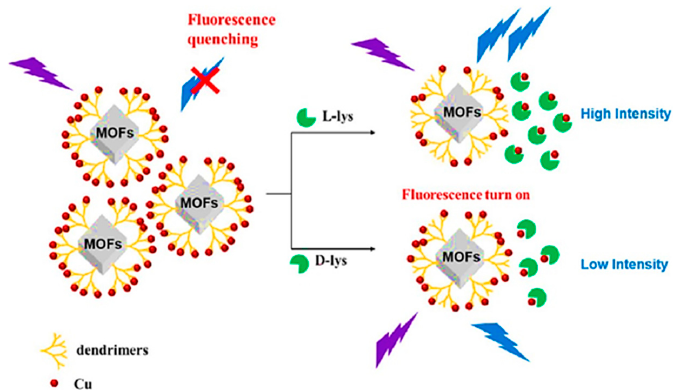
Figure 5. Achiral luminescent MOFs grafted onto PAMAM for enantioselective sensing of lysine enantiomers. Reprinted (adapted) with permission from [61]. enantiomers. Reprinted (adapted) with permission from